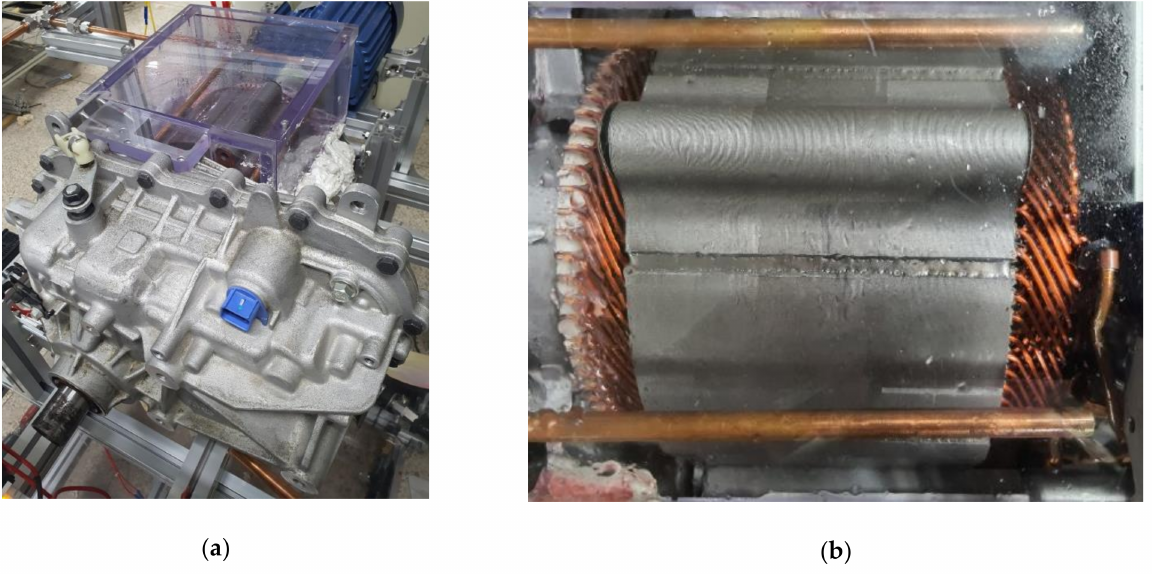
Figure 1. Target motor: ( a ) motor assembly; and ( b ) stator and